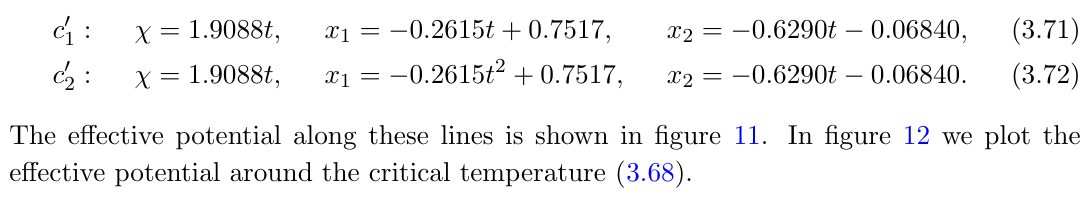
Figure 10 . The potential V e(cid:11) ( L; (cid:31); T ) =T 4 around T c; 4 = (cid:3) H = 6 : 670 as a function of (cid:31) (left), ‘ (center) and p (right) on the two di(cid:11)erent lines c 0 in (3.64) and